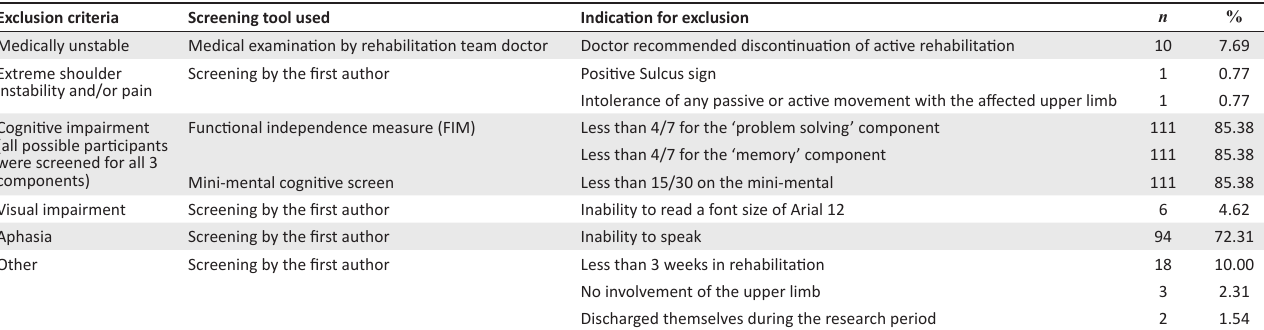
TABLE 1: Reasons for excluding possible candidates from study ( n =